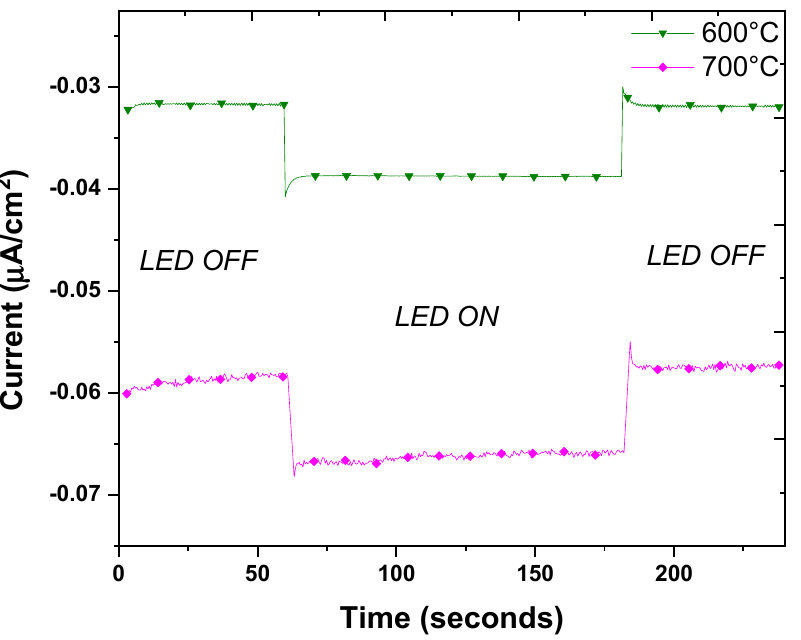
Figure 6. Current-time measurements obtained with an applied voltage of − 2 V on the LMO film after annealing at 600 and 700 °C and exposed or not to an LED light.